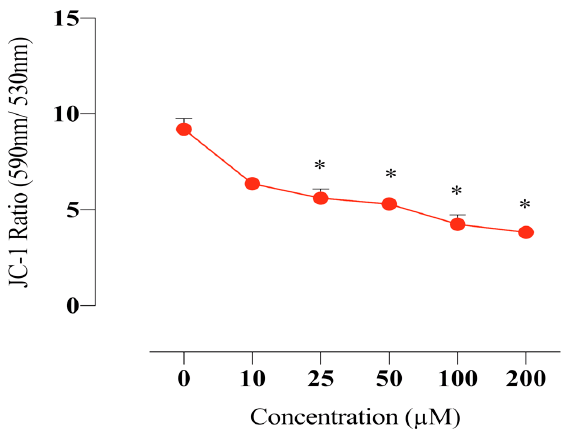
Figure 6. Measurement of the MMP in HeLa cells. The cells were stained with the JC-1 dye, and spectrofluorimetric assay was performed to determine the MMP. A 25 µM dose of compound E inhibited CAIX and disrupted MMP in a dose-dependent manner. The data are presented as the mean ± SD (n = 3). * p < 0.05 compared with the control.